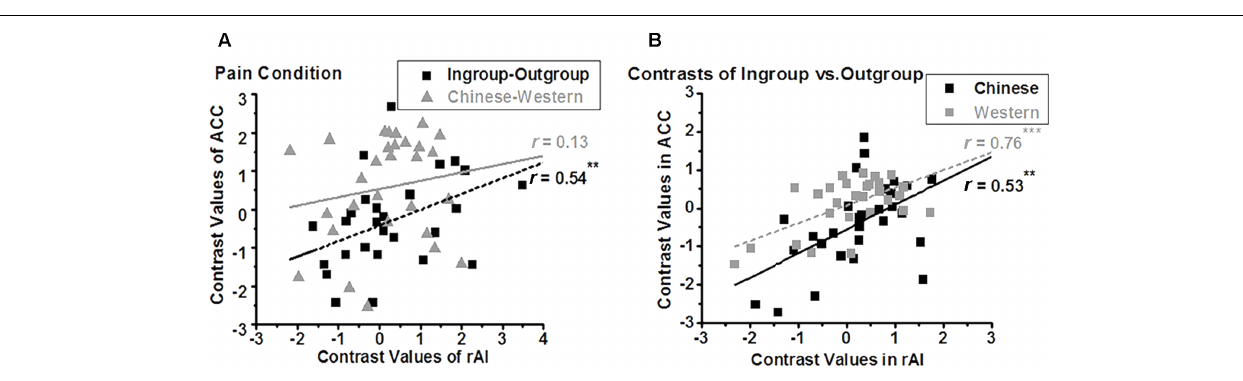
FIGURE 6 | Neural activity of ACC is modulated by ingroup bias in pain condition (A) , both for Chinese and Western (B) . In the pain condition, a positive correlation was found between the contrasts of Ingroup vs. Outgroup (i.e., ingroup bias) of rAI and that of ACC ( A , rectangle, ∗∗ adjusted p < 0.01), both for Chinese